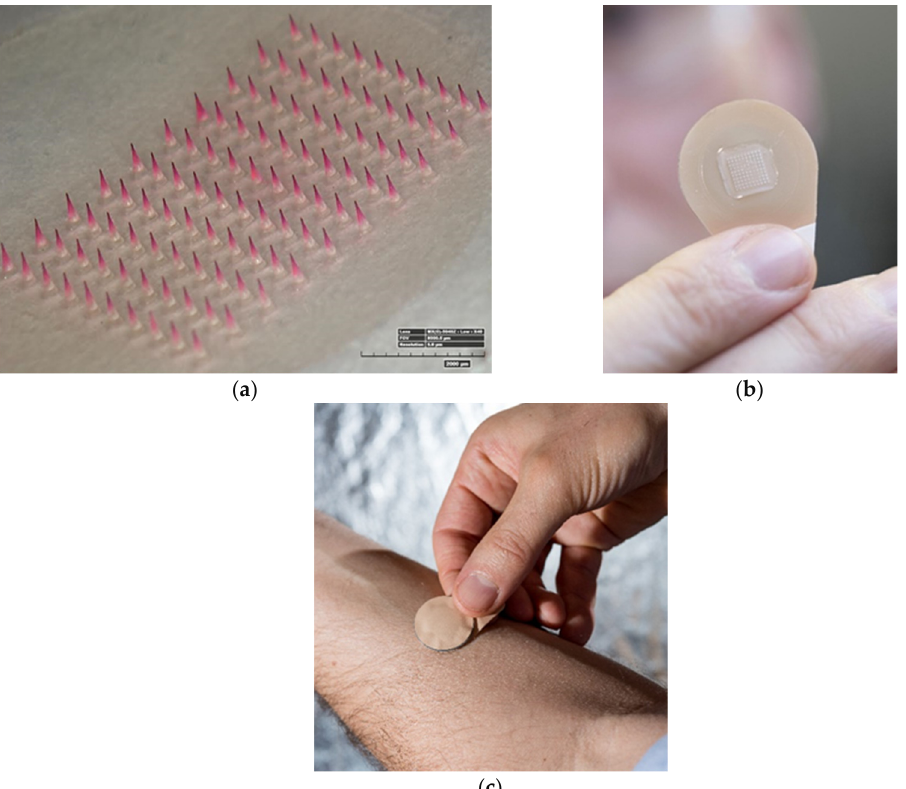
Figure 1. Dissolvable microneedle patch for simplified vaccination. ( a ) An array of microneedles containing pink dye to simulate vaccine. A microneedle patch ( b ) showing the microneedle array, adhesive backing, and non-adhesive tab for handling. ( c ) A microneedle patch being applied to the skin. Images courtesy of ( a ) Devin McAllister, Georgia Tech, ( b ) Christopher Moore, Georgia Tech, and ( c ) Rob Felt, Georgia Tech.